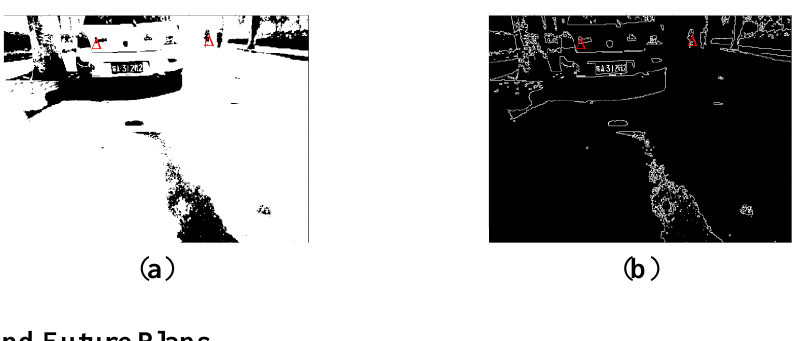
Figure 13. ( a ) Shadow detection result without segmentation of potential region ( b ) Edge detection result without